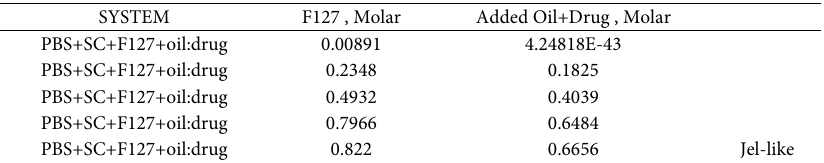
Table 8. Titration of turbid solution of F127, SC, oil+drug in PBS with F127 and Oil+Drug (1:1 molar ratio) ([PBS]=Const. , [Sodium Caprylate (SC)]= Const.).